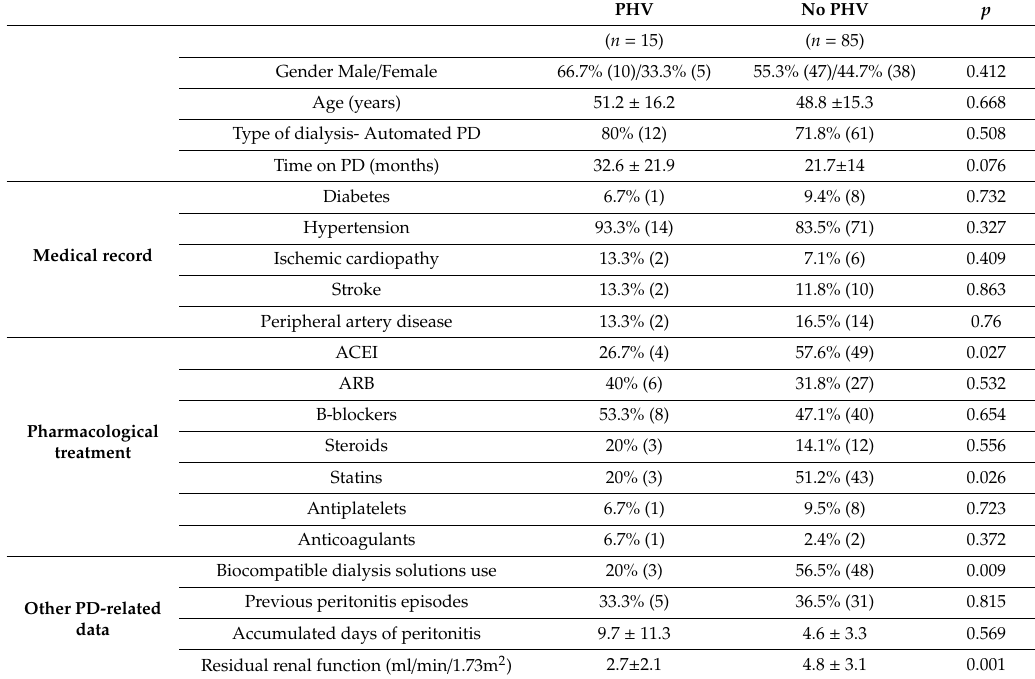
Table 1. Clinical characteristics of Spanish